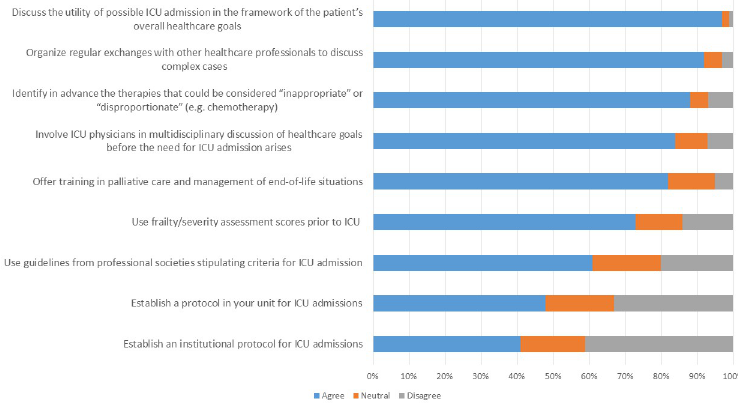
Fig 4. Level of reported agreement with the proposed measures to avoid admissions that later come to be considered as “non-beneficial” (Domain 4 of the